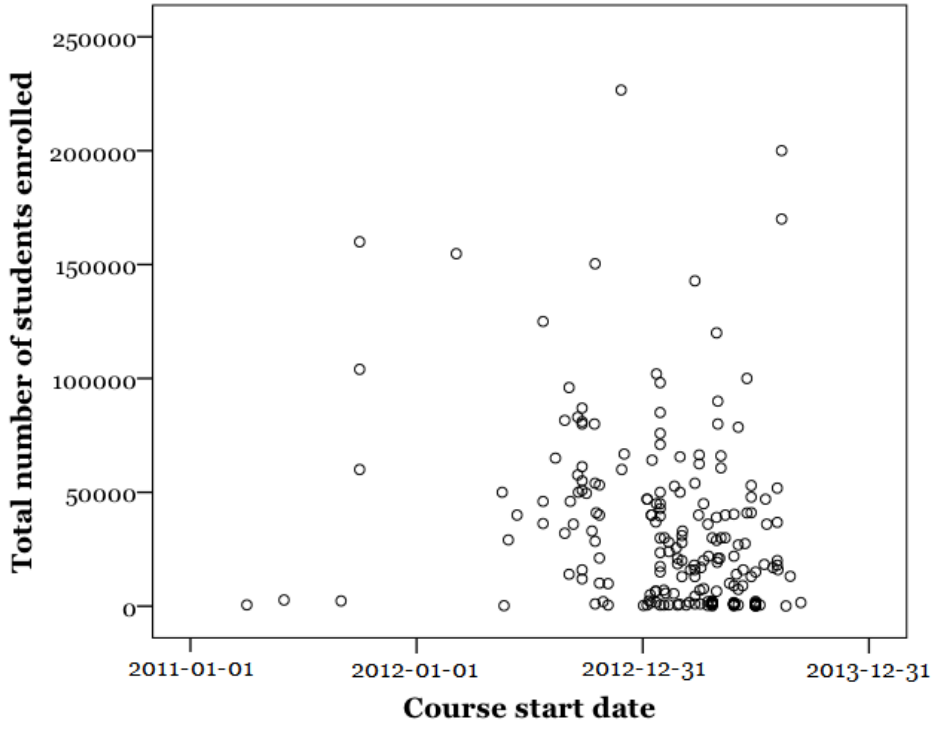
Figure 1 . Scatterplot of MOOC course enrolments plotted against course start date